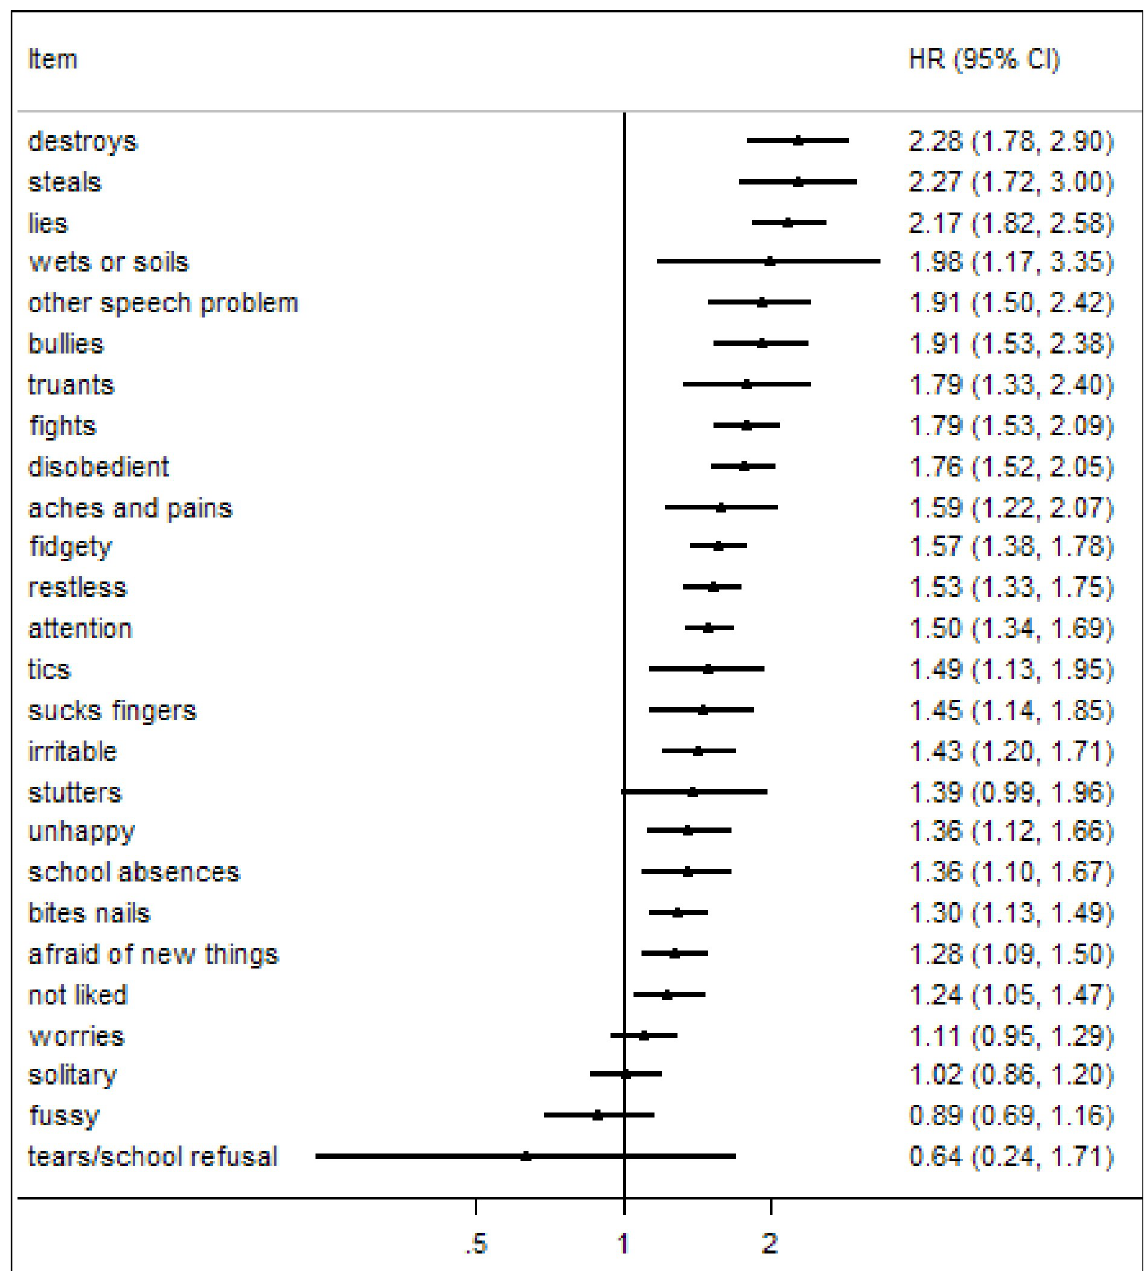
Fig 1. Mortality risk associated with each of the Rutter B items (n =